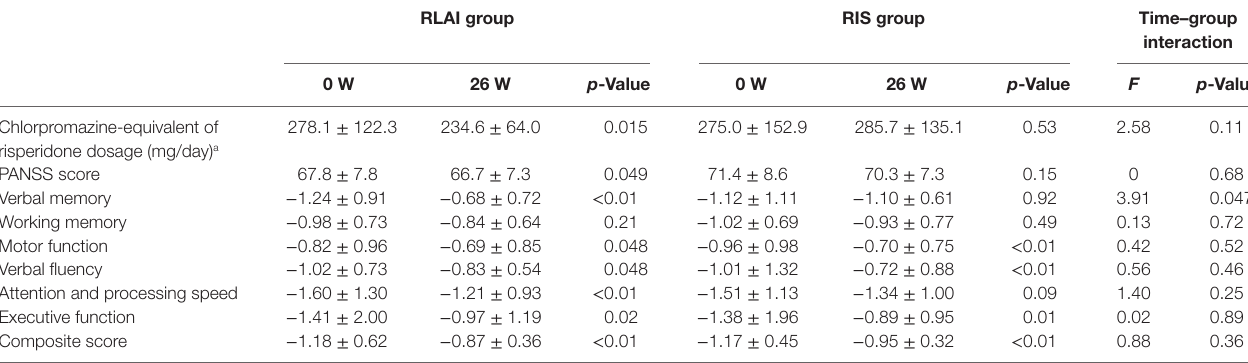
TaBle 2 | Cognitive function changes in the RLAI and RIS